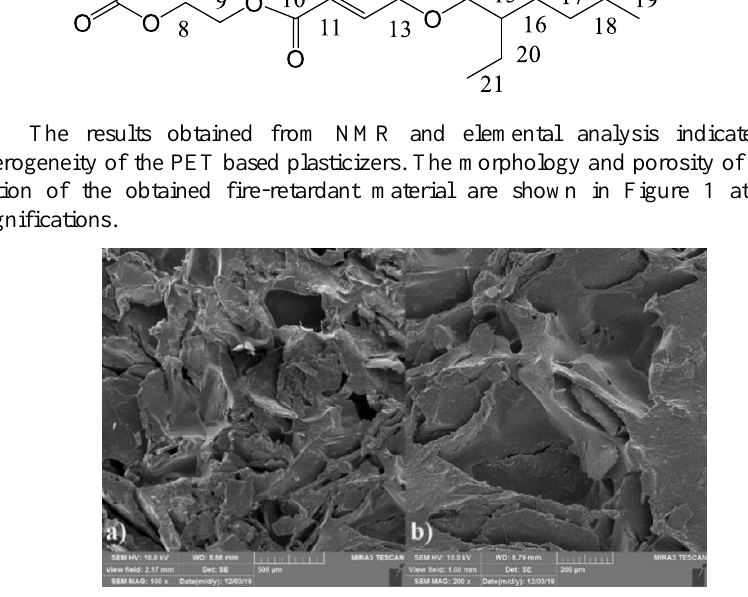
Fig. 1. The morphology of the cross-section of the obtained FR material (Sample 3) at different